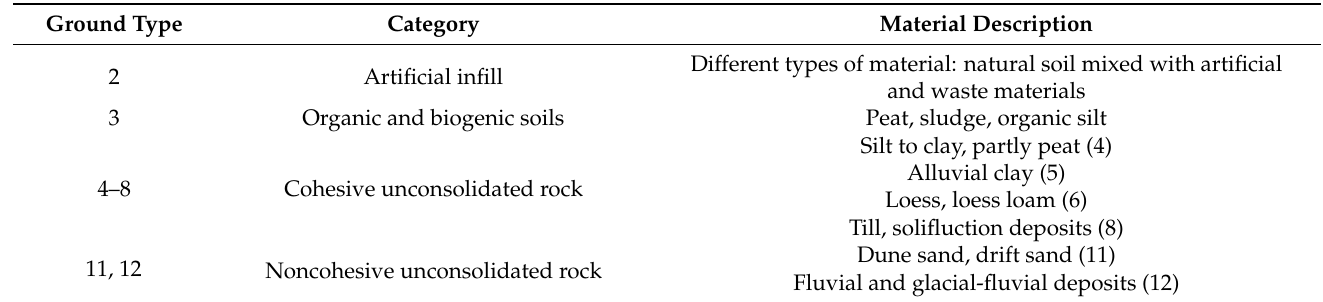
Figure 3. Schematic profile to illustrate the underestimated slope values at road cuts in the Harz mountains. The steep-cut slope is not resolved in the elevation model of 20 m.